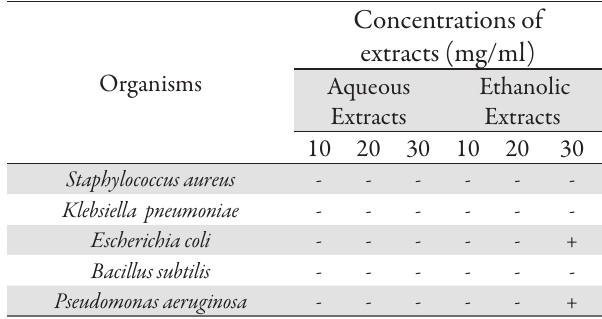
Tab. 4. The bacteriostatic effects of aqueous and ethanolic extracts of Allium sativum